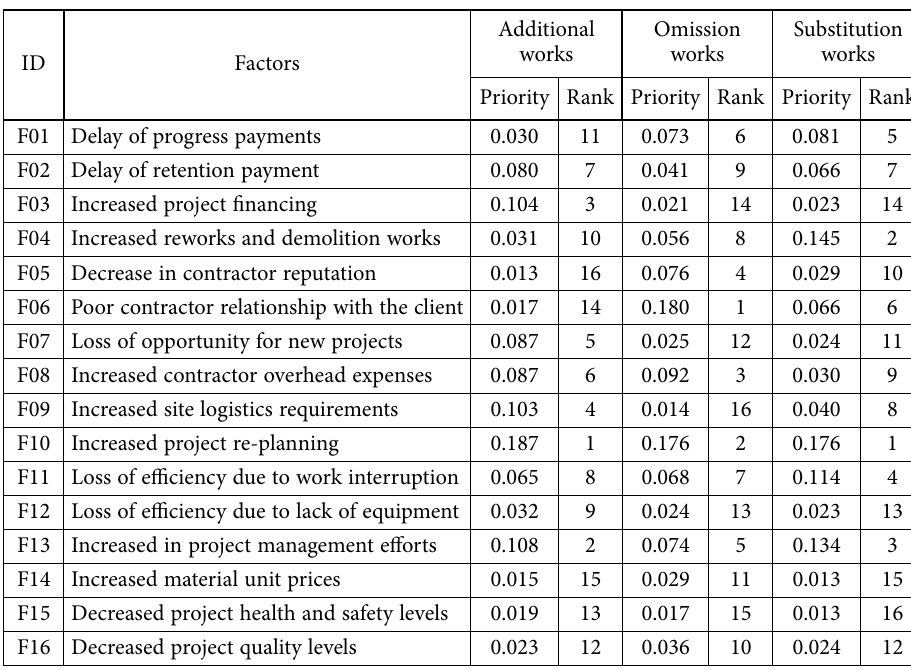
Figure 4. Priority values matrices multiplication and result of overall Table 8 shows ranking for each change order type. Table 8. Factors ranking using AHP for each change order type and overall ranking